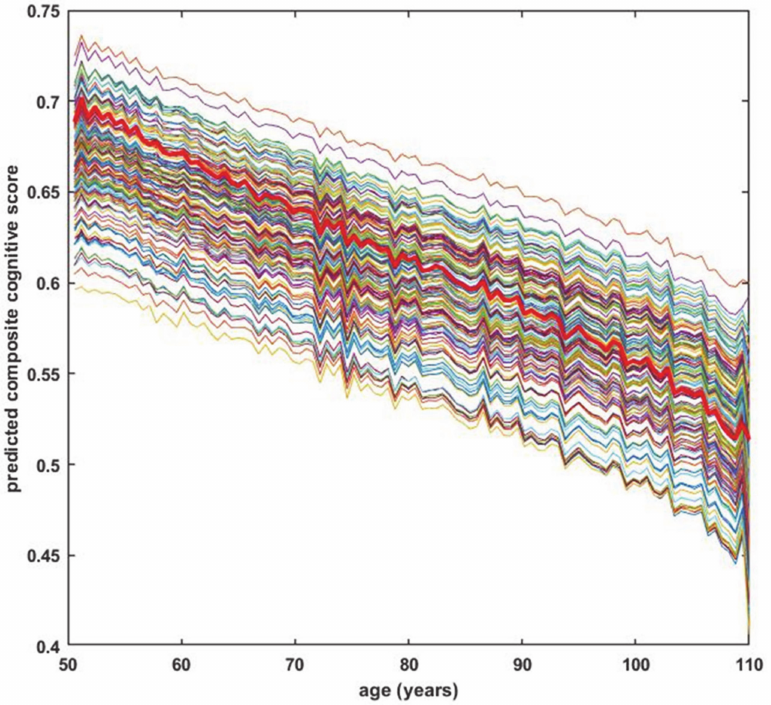
Figure 2. The combined cognitive scores as predicted by a single ANN for each age in the age- advancing sequence for 65 representative drug combinations (every 2000th combination selected from the full set of 131,072 combinations of 17 drugs). Each output unit represented the score of a different cognitive test, so the combined cognitive score was the average over the output unit activations. The combined cognitive score in the no-drug case is shown as a heavy red line. These results show that a substantial proportion of drug combinations are predicted to improve cognitive performance above the no-drug case in a cohort of elderly participants. This ANN was trained on the ROSMAP dataset. The results for ANNs trained on the NACC dataset are similar (Supplementary Figure